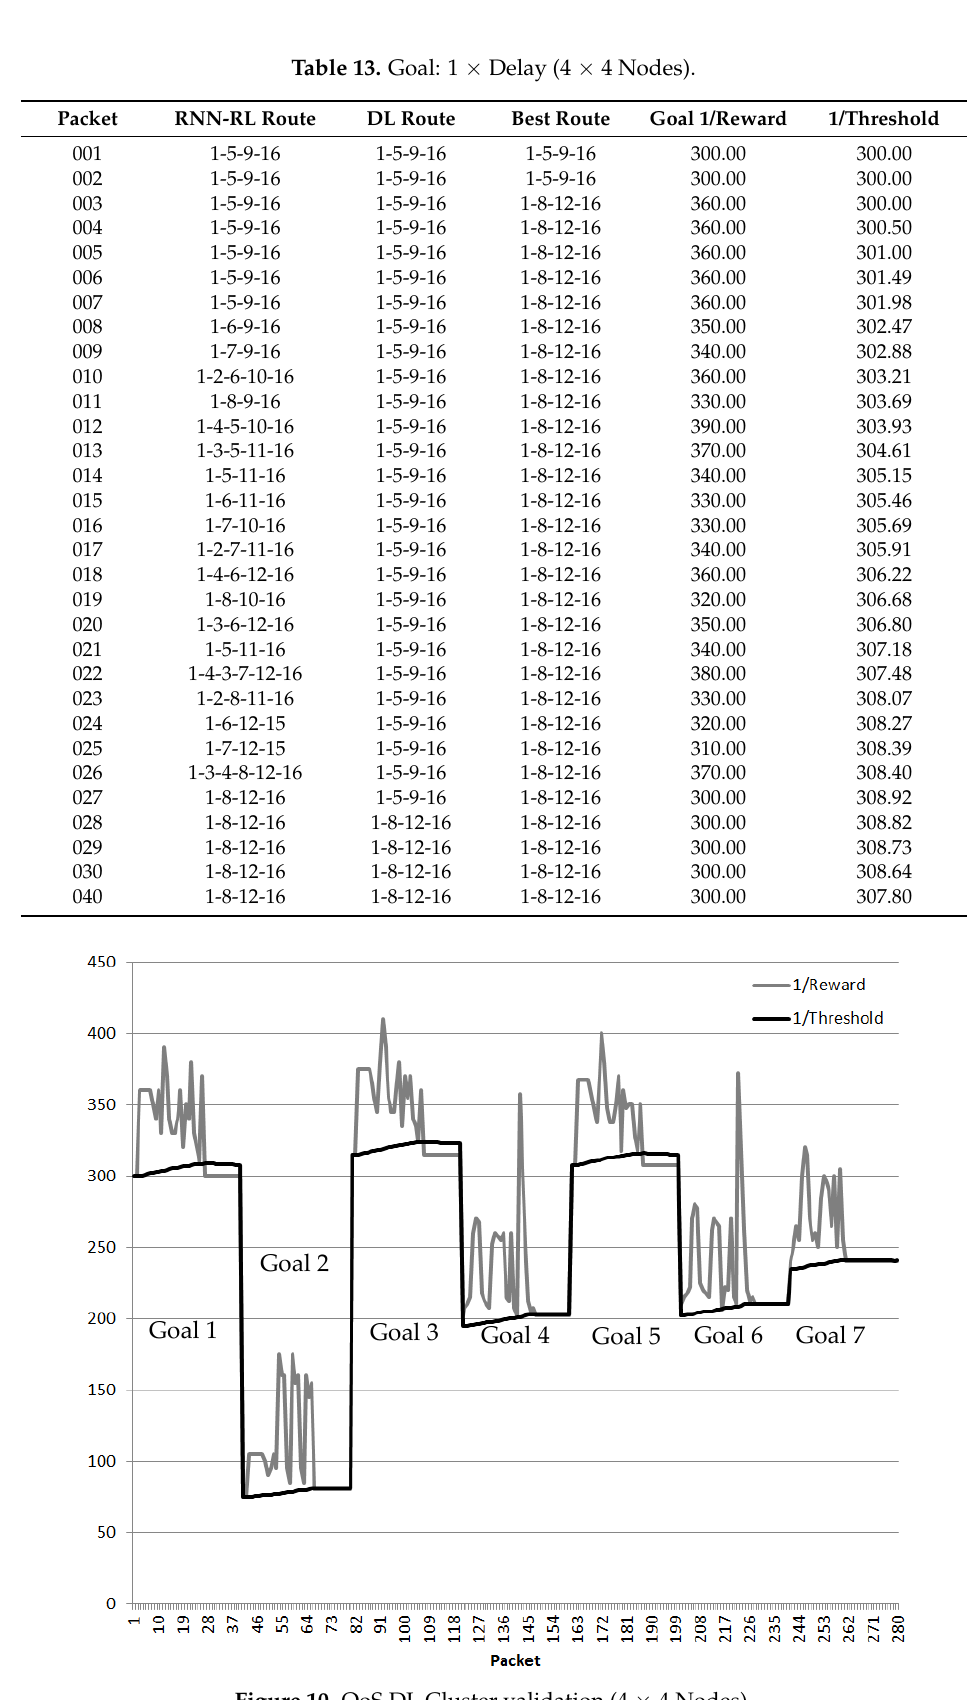
Figure 10. QoS DL Cluster validation (4 × 4 Nodes).